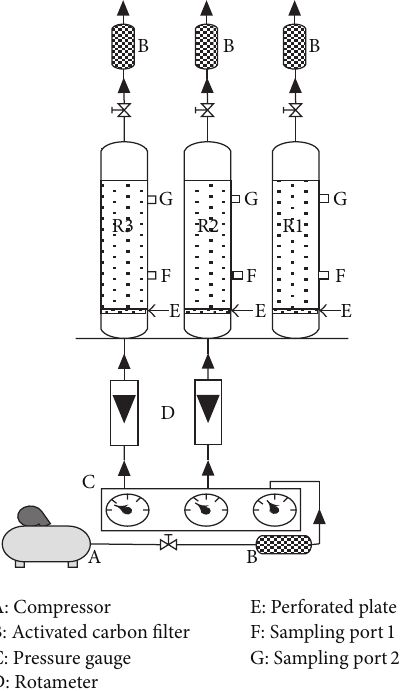
Figure 2: Experimental setup for BV, SVE, and AIBV [reactor 1 (R1): sandy soil + inoculum/MM, reactor 2 (R2): sandy soil + inoculum/MM + Air injection, reactor 3 (R3): sandysoil + sterilized water + air injection].